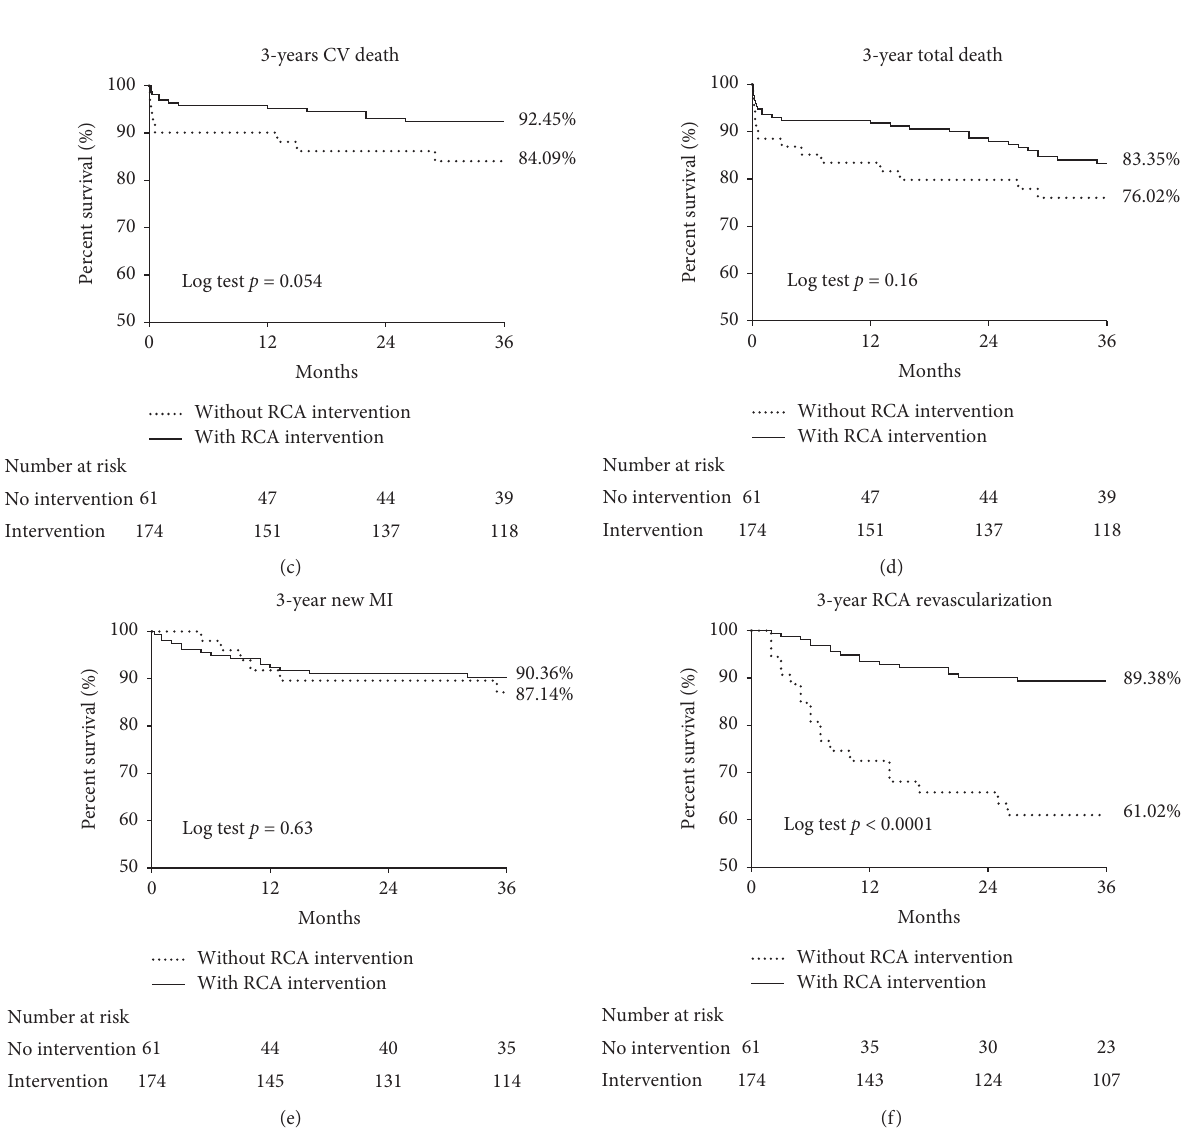
Figure 1: Kaplan–Meier curves for event-free survival. Solid line—patients with concomitant left main disease and RCA significant stenosis ( > 70% stenosis) and received PCI to left main disease and right coronary artery at the same hospitalization; dotted line—patients with concomitant left main disease and RCA significant stenosis ( > 70% stenosis) only received PCI to left main disease and was discharged with residual RCA significant stenosis. (a) 30-day cardiovascular death-free survival. (b) 30-day total death-free survival. (c) 3-year cardiovascular death-free survival. (d) 3-year total death-free survival. (e) 3-year new myocardial infarction-free survival. (f) 3-year RCA revascularization- free survival.